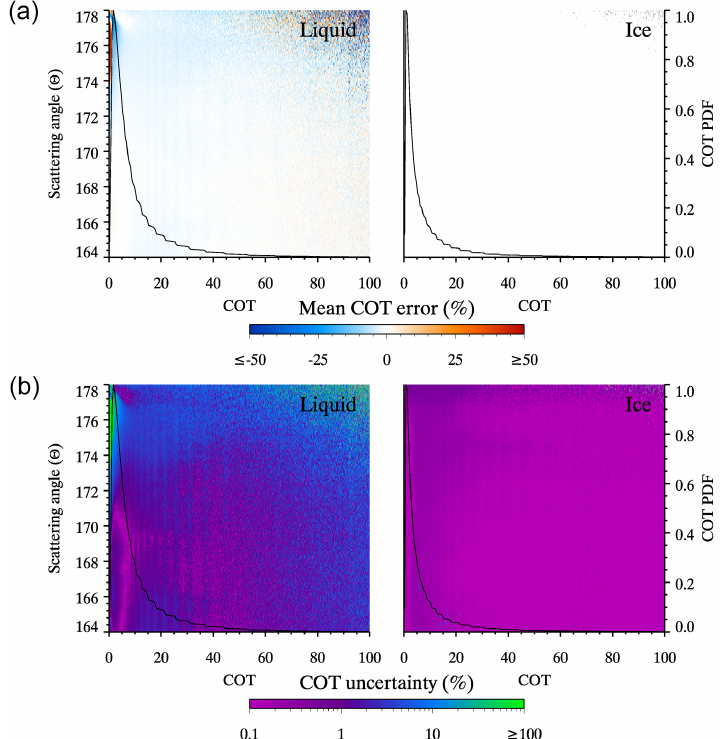
Figure 9. Mean single-channel COT retrieval error (a) and uncertainty (b) , with respect to the baseline two-channel COT-CER retrievals, as a function of COT and scattering angle for the entire April 2005 Aqua MODIS granule subset, limited to scattering angles greater than 164 ◦ (see Fig. 1). COT retrieval error (i.e., relative difference or bias) and uncertainty are defined as the mean and standard deviation of the histograms in Fig. 8. Black lines denote the COT retrieval